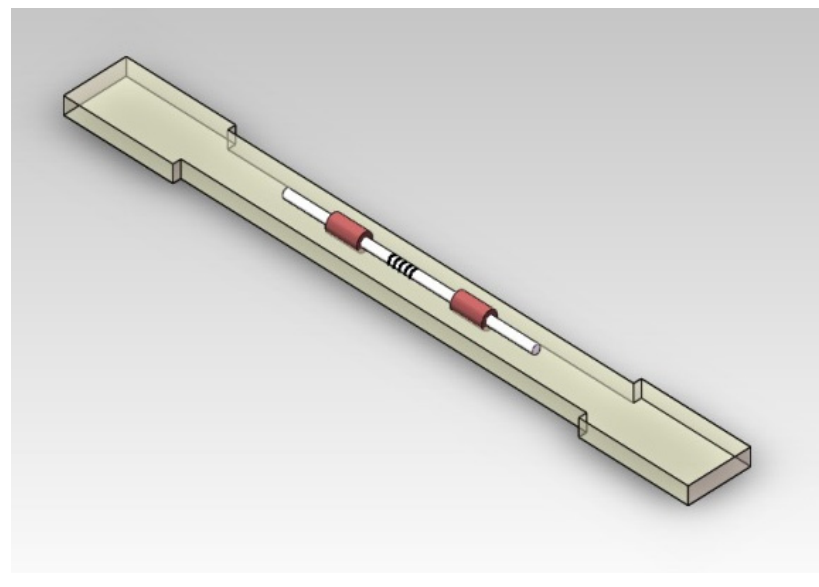
Figure 8. Matrix material.